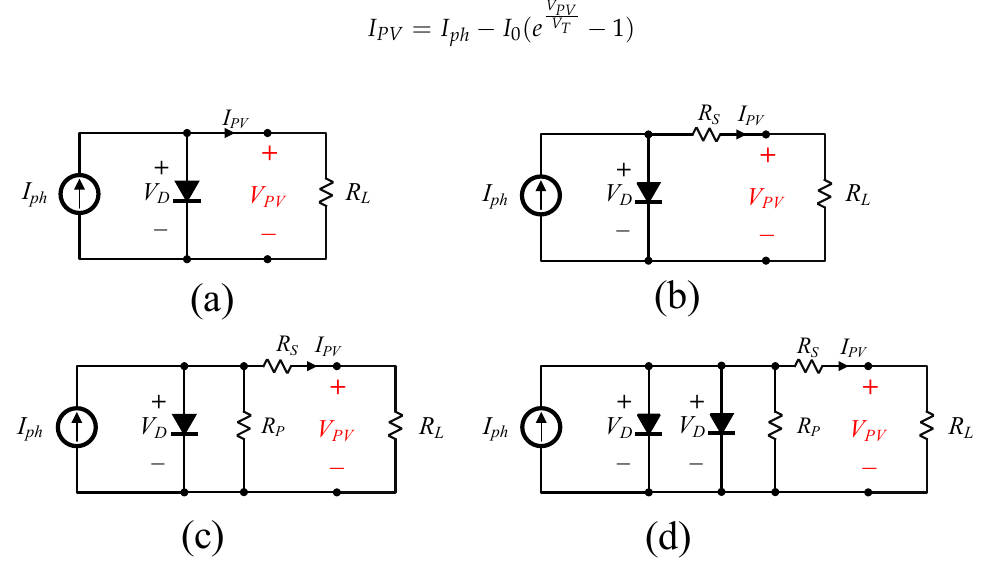
Figure 1. Several PV models: ( a ) the ideal model, which is lossless; ( b ) single diode with series resistance; ( c ) single diode with series and parallel resistances; ( d ) the two-diode